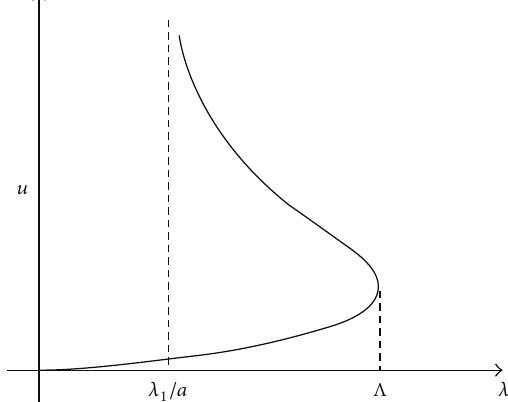
Figure 1: Diagram for Λ = 𝜆 1 /𝑎 .